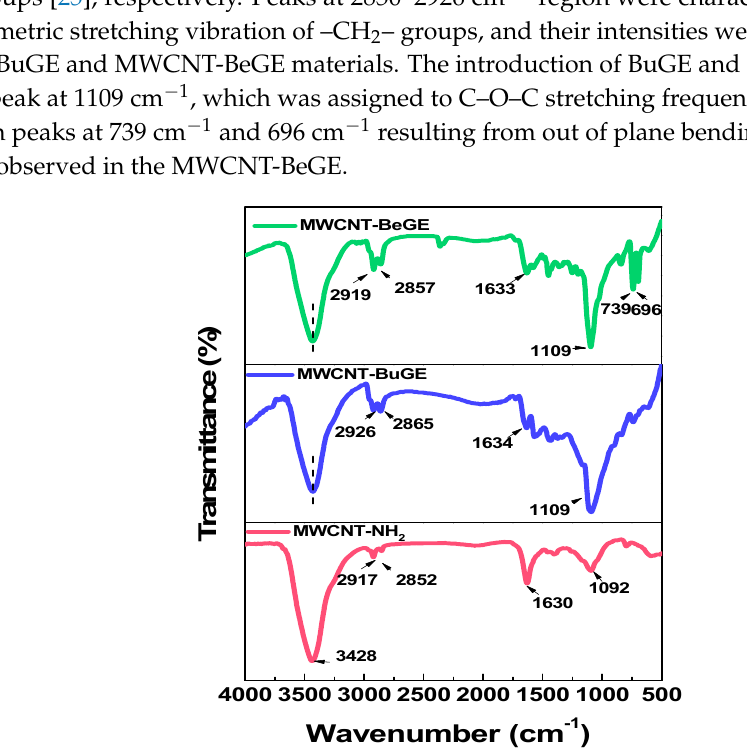
Figure 5. Fourier-transform infrared spectroscopy (FT-IR) spectra of MWCNT-NH 2 , MWCNT-BuGE and MWCNT-BeGE.